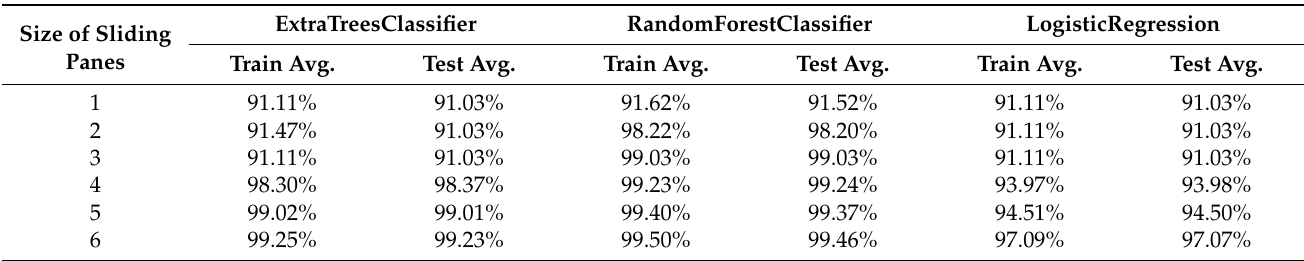
Table 8. Influence of the sliding pane on the accuracy of different classifiers.